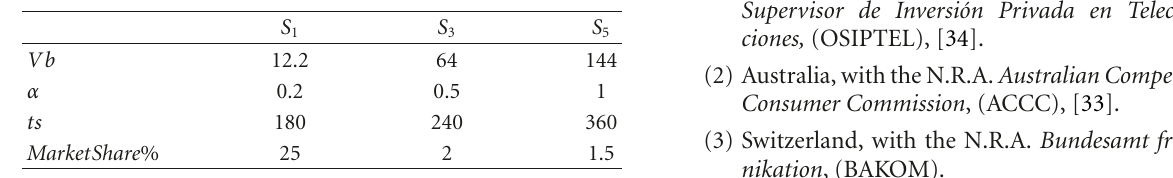
Table 13: Values for spanish scenario.